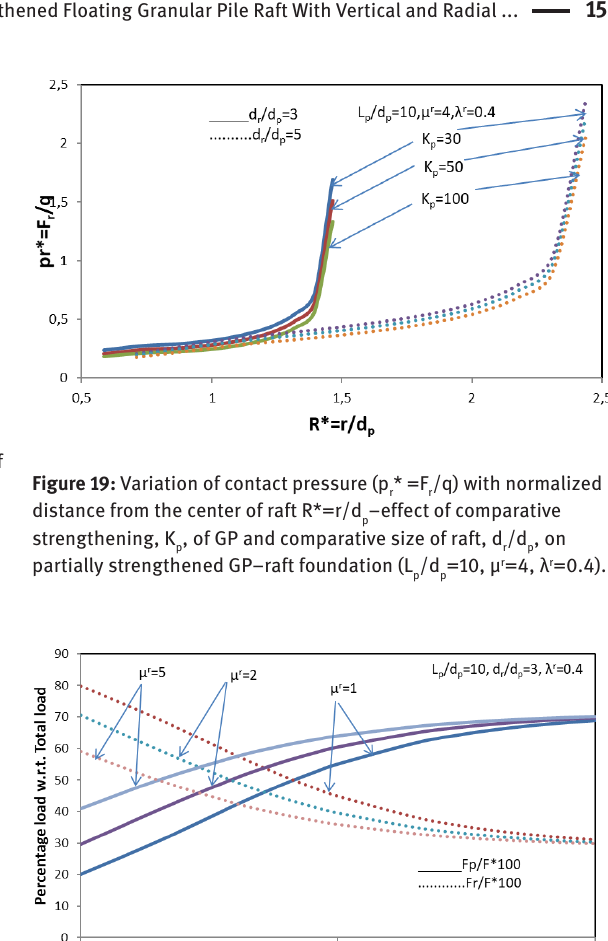
/q) with normalized r –effect of strengthening p Figure 20: Variation of percentage load w. r. t. total load with the =50, L /d =10, d / p p p r comparative strengthening of GP, K strengthening of GP, μ r , on a partially strengthen GP–raft